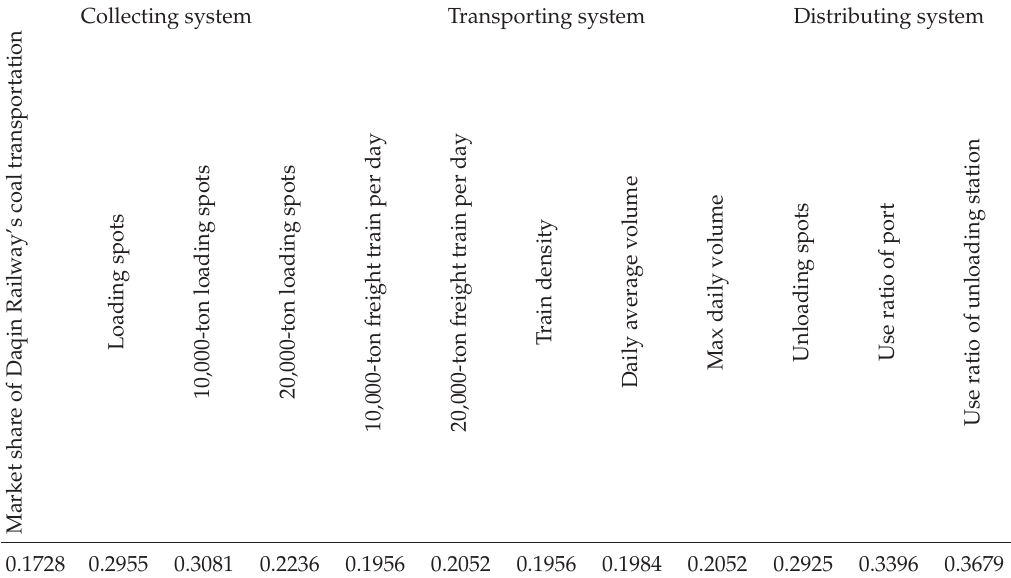
Table 2: Weight of each subsystem’s parameters.